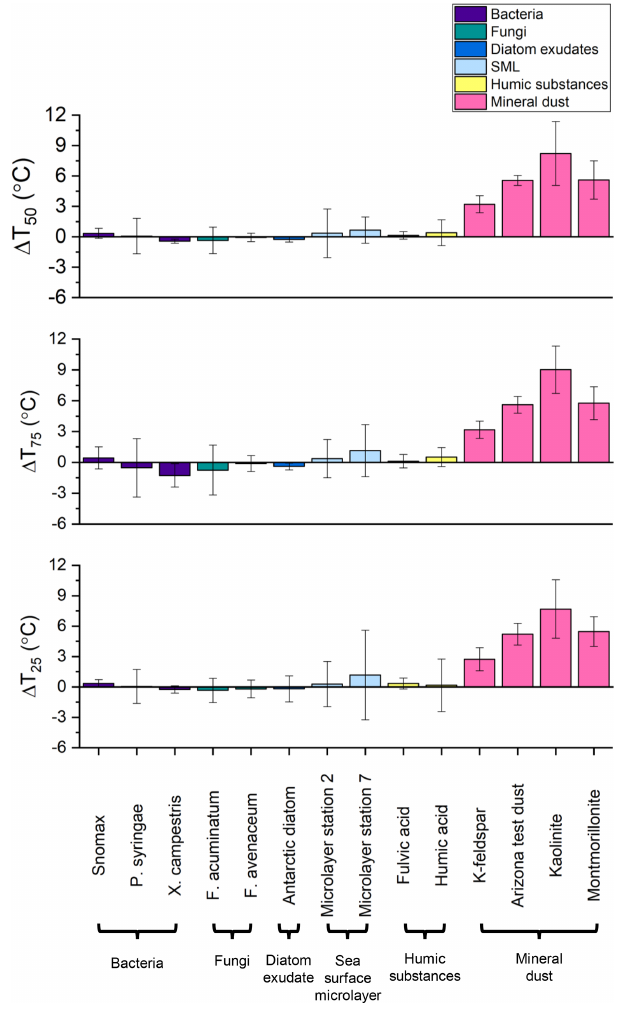
Figure 8. Change in the temperature at which 50% ( (cid:49)T 50 ) , 75% ( (cid:49)T 75 ) , and 25% ( (cid:49)T 25 ) of sample droplets were frozen between samples with (NH 4 ) 2 SO 4 added and samples without (NH 4 ) 2 SO 4 added. Error bars represent the 95% confidence interval calculated using Student’s t distribution. Freezing data have been corrected for freezing point depression by 0.05M(NH 4 ) 2 SO 4